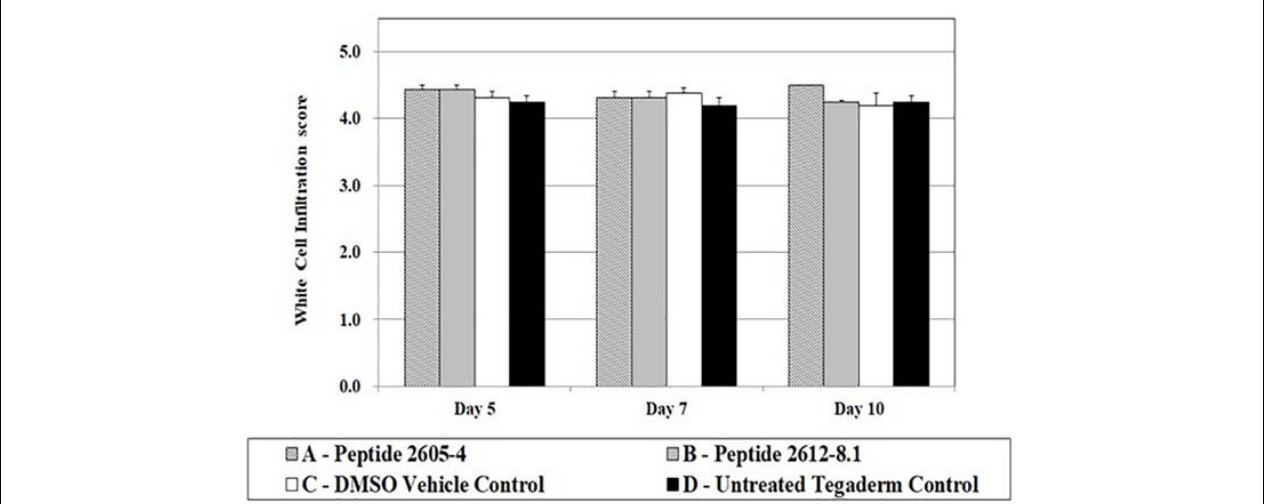
FIGURE 5 | White cell infiltrate quantification upon treatment. White cell infiltrate was measured by the presence and amount of subepithelial mixed leukocytic infiltrates (mean score: 1 = absent, 2 = mild, 3 = moderate, 4 = marked, 5 = exuberant) at days 5, 7, and 10 post-treatment. No significant differences were seen among treatment groups; n = 8 per each treatment group, per time point.